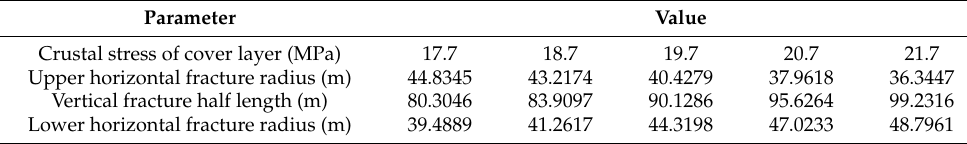
Table 3. Fracture geometry changes with crustal stress of cover layer.